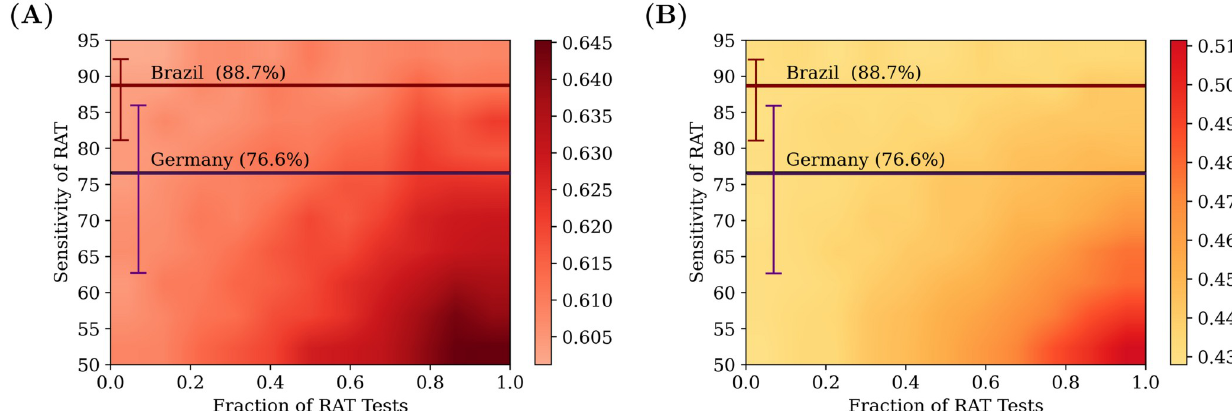
Fig 6. Comparing different test mixtures. Heatmaps comparing the effects of different test mixtures for two daily testing rates: 0.1% (left) and 0.5% (right), with testing starting when the recovered fraction reaches 20% of the population. The colours represent the total fraction of the population that had contracted the disease at some time. The x –axis represents the fraction of RAT tests in the testing mixture used, and the y –axis represents the test sensitivity of the RAT in the mixture. The horizontal lines represent the sensitivities of the SD Biosensor STANDARD Q COVID-19 Ag Test from surveys conducted in Germany and Brazil [46]. The specificity of the RAT is kept at 98%. At lower RAT sensitivities, there is a benefit of using a larger fraction of PCR tests, however as the RAT sensitivity is increased, this benefit is soon lost. The tests were assumed to have no delay between sampling and declaring of results; individuals who tested positive were confined to their homes and assumed to be ten-fold less infectious. However, homes were not quarantined, and other family members were allowed to move to work. 100 simulation runs of 200 days each were averaged over.